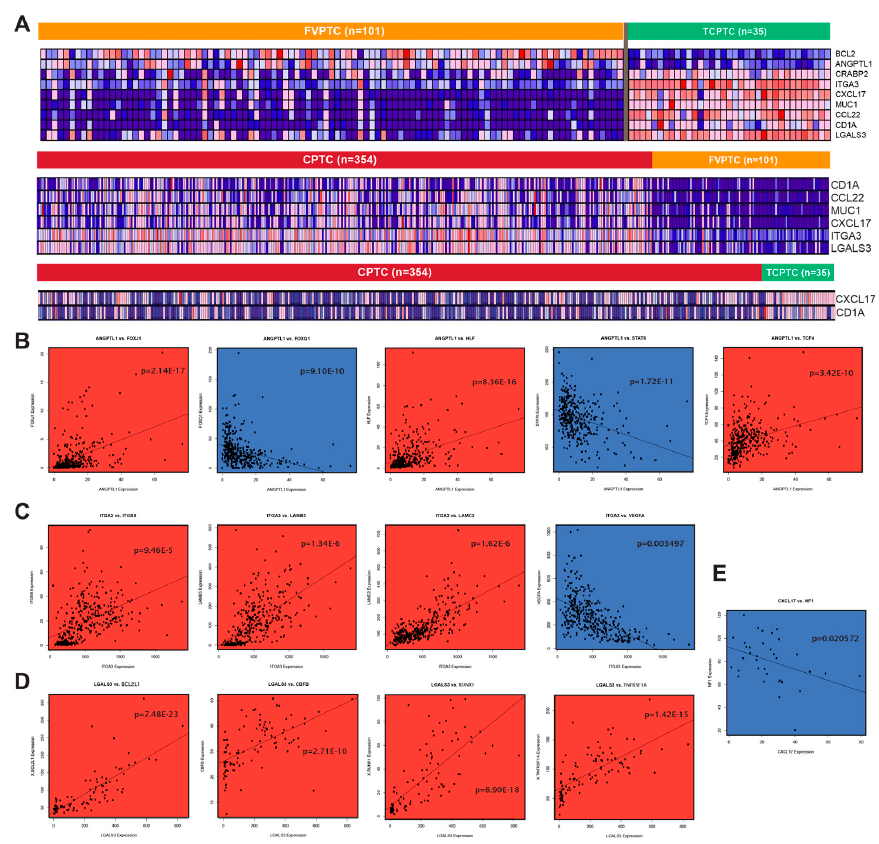
Figure 5. Analysis of gene expression di ff erences between PTC subtypes. ( A ) Heatmap visualizing the di ff erential expression of a panel of important CA / IA genes after comparing the three PTC subtypes against each other. ( B ) Scatter plot of ANGPTL1 expression vs. expression of related genes in CPTC samples. ( C ) Scatter plot of ITGA3 expression vs. expression of related genes in CPTC samples. ( D ) Scatter plot of LGALS3 expression vs. expression of related genes in FVPTC samples. ( E ) Scatter plot of CXCL17 expression vs. NF1 expression in TCPTC samples.